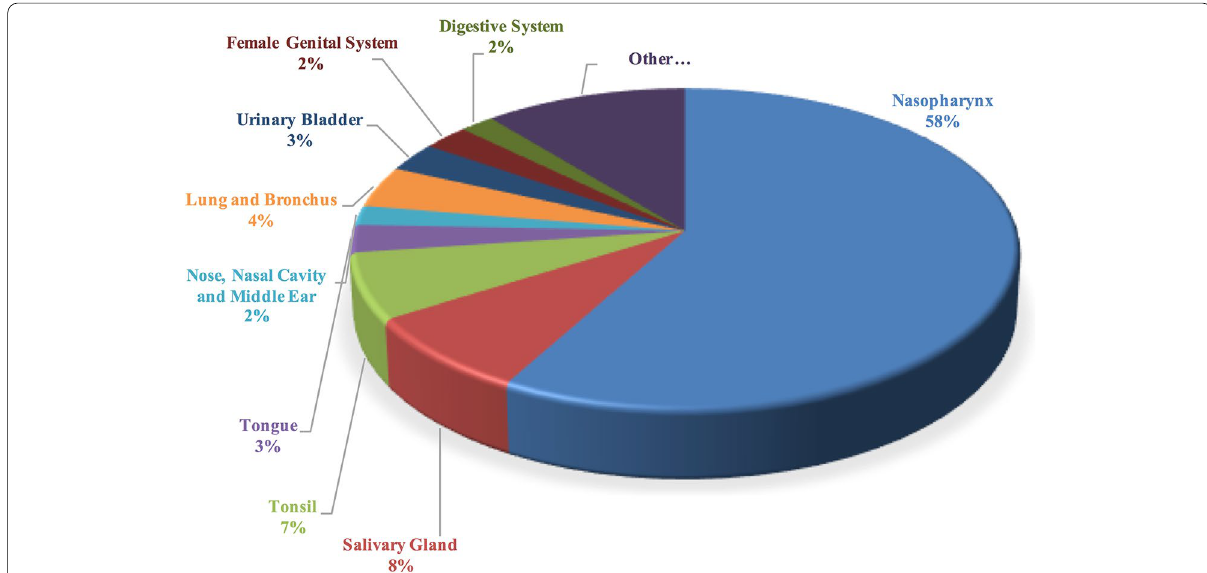
Fig. 2 The distribution of LELC at different anatomic